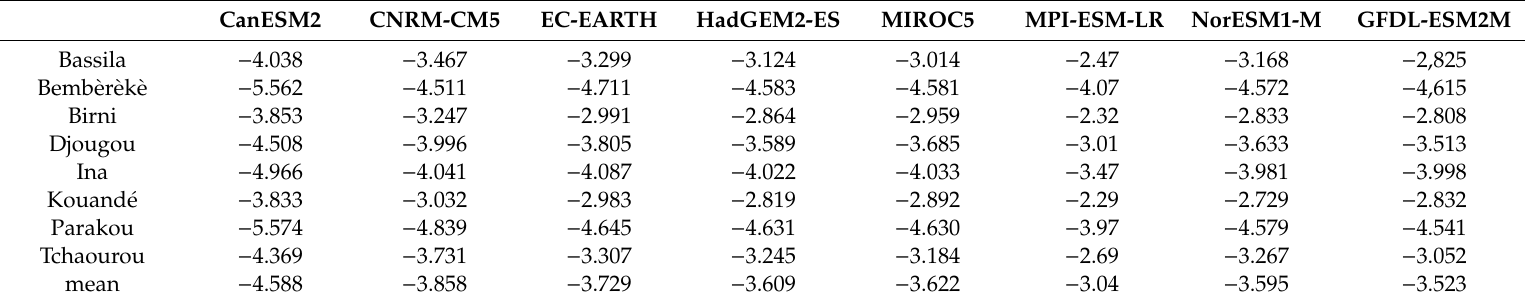
Table 5. Deviations of standard deviations of observed and simulated precipitations by models over the period 1951–2005.